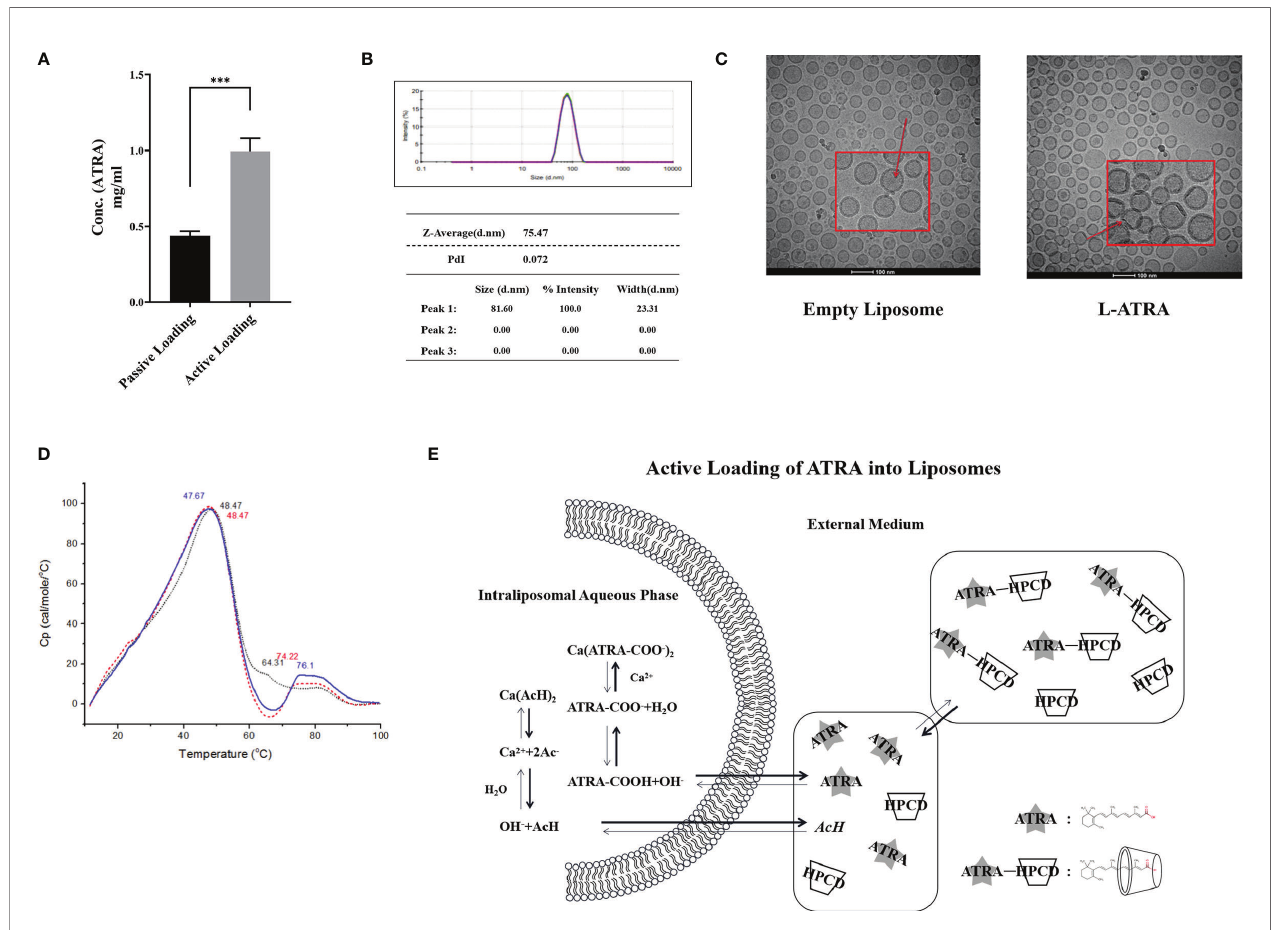
FIGURE 1 | L-ATRA preparation and characterizations. (A) Concentrations of ATRA liposomes prepared using passive loading or active loading procedures; (B) Particle size distribution and PDI of L-ATRA; (C) Representative cryoEM images of empty liposomes (left) and L-ATRA (right); (D) The nano-DSC thermograms of L- ATRA; (E) Schematic drawing of the active loading mechanism for preparing L-ATRA. The p value for the symbol *** were < 0.001 (p=0.0005, student